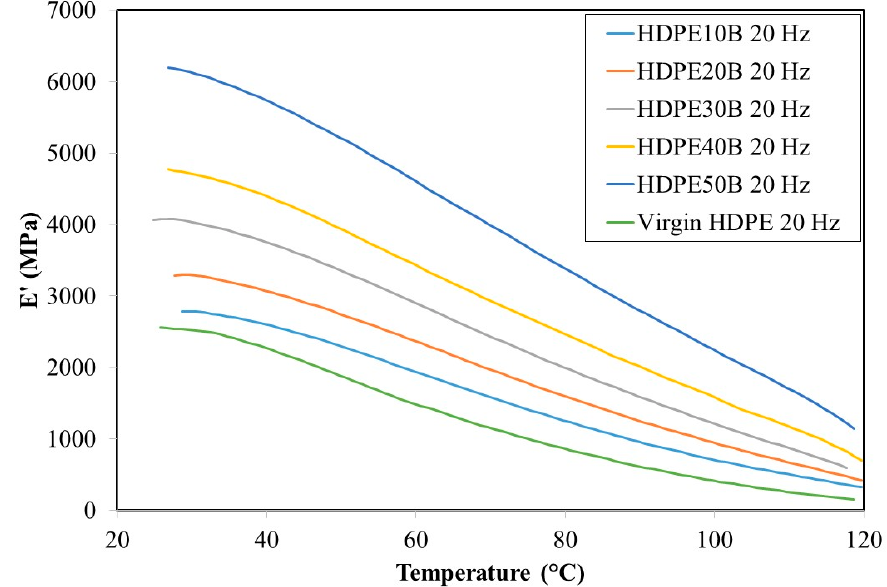
Figure 7. Storage modulus of HDPE/birch fiber composites at 20 Hz.